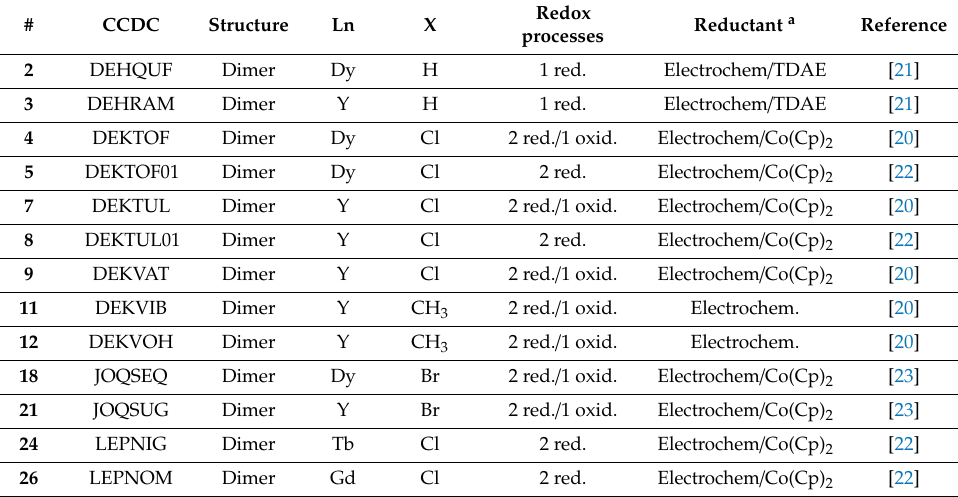
Table 31. Ln-anilato compounds with reduced anilato ligands.